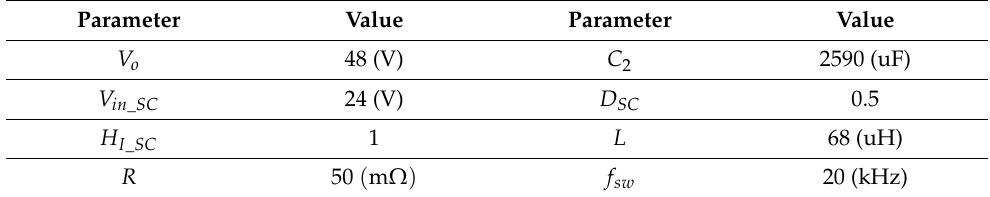
Table 5. Parameters of the SC